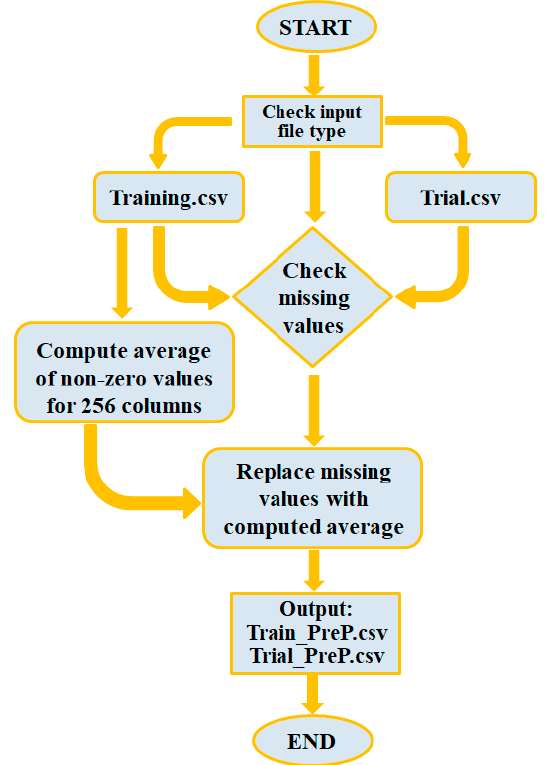
Figure 4. Flow graph for the proposed pre-processing algorithm.